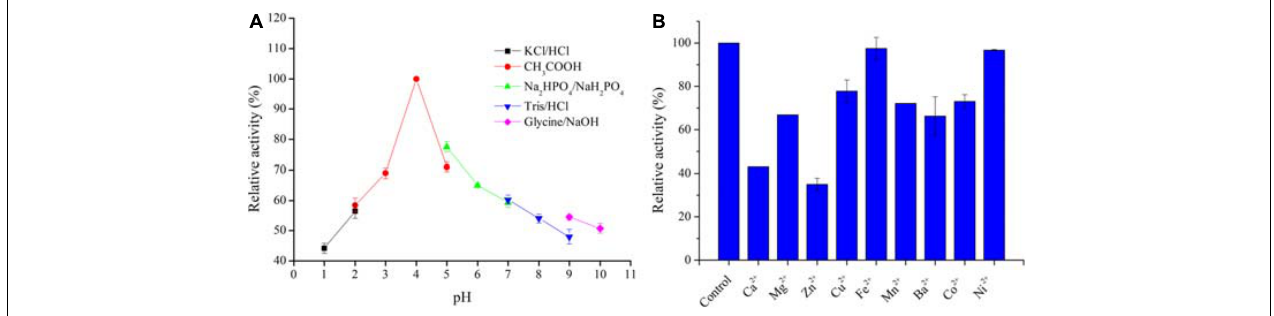
FIGURE 7 | Stabilities of Aa SOD in buffers with different pH values (A) and effect of divalent ions on the Aa SOD activity (B) . The purified enzyme was incubated in the buffer systems of 200 mM KCl–HCl buffer (pH 1.0–2.0), acetate buffer (pH 2.0–5.0), sodium phosphate buffer (pH 5.0–7.0), Tris–HCl buffer (pH 7.0–9.0), and glycine–NaOH buffer (pH 9.0–10.0) for 1 h, 25 ◦ C. The maximal activity was taken as 100% for relative activity calculation. For metal ions effects, the purified enzyme was incubated with 1 mM of divalent metal ions in 50 mM Tris–HCl buffer (pH 8.0), at 25 ◦ C for 30 min. The mixture with no ions supplementation was used as a control for relative activity